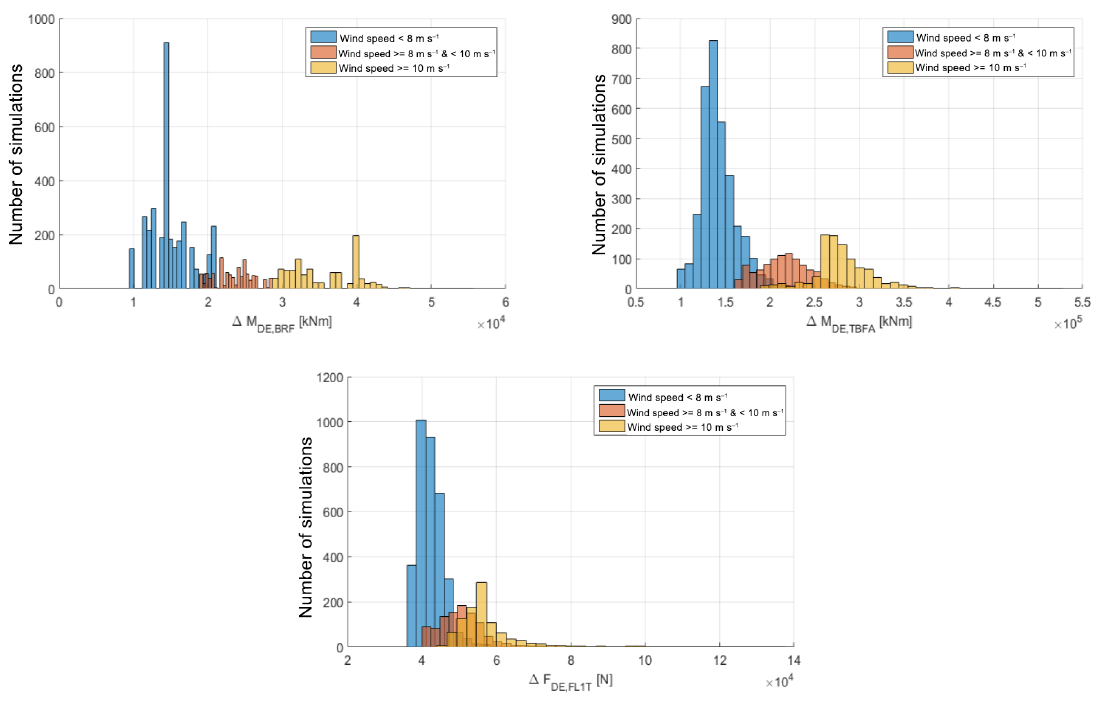
Figure 10. Histograms of simulated DELs across different wind speed ranges for different load